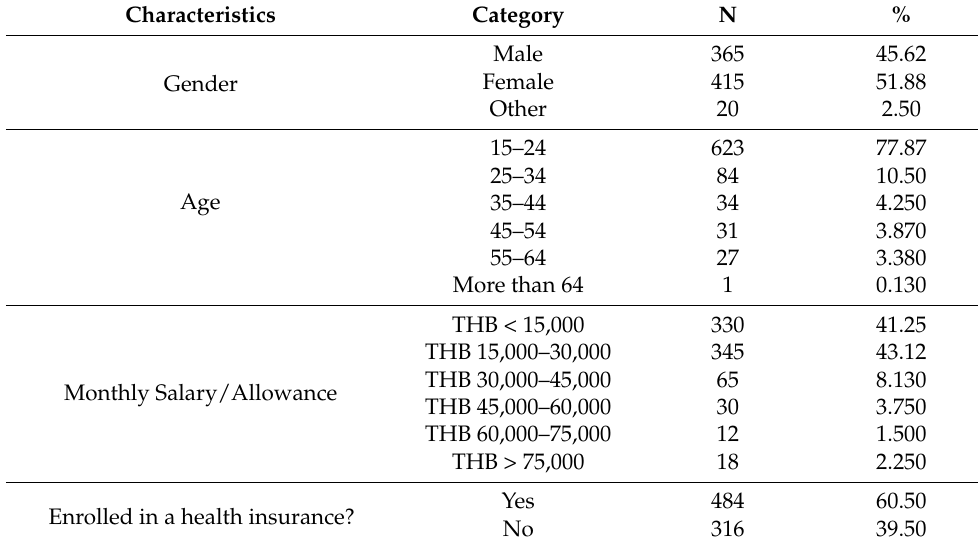
Table 2. Demographic Profile of Respondents (n = 800).